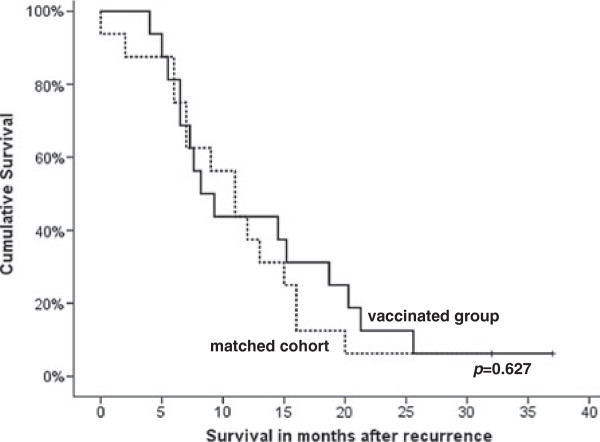
Comparison of overall survival after cervical cancer recurrence between vaccinated patients and a matched cohort of non-vaccinated cervical cancer patients. The survival of the group of 16 vaccinated patients with a cervical carcinoma was compared to a cohort group of non-vaccinated patients who where primarily matched for FIGO stage, time to recurrence, primary treatment and salvage therapy after recurrence and which turned out to be matched also for age of diagnosis, age of recurrence, the type of primary and salvage chemotherapy as well as for adjuvant therapy. Both the log-rank and the Wilcoxon signed rank test revealed no difference in survival between the two groups.